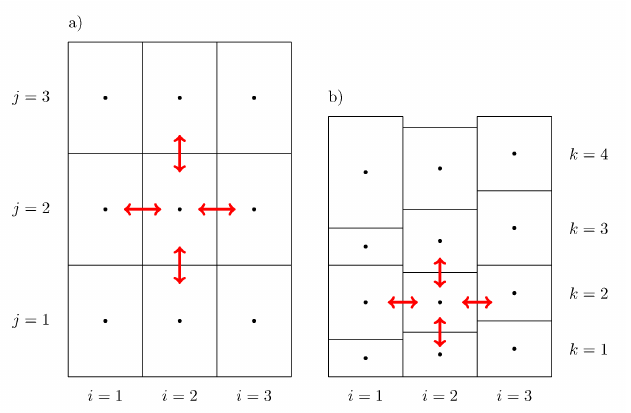
Figure 1. ( a ) Plan view of a domain’s layer; ( b ) vertical section view. Red arrows are examples of groundwater fluxes through first-neighborhood cells and considered in the discrete model.